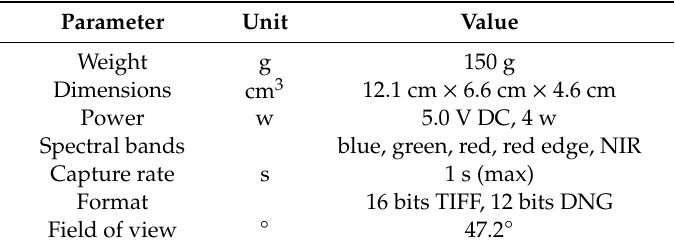
Figure 1. Rededge- M multi-spectral camera. Note: 1. Blue band 2. Green band 3. Red band 4. NIR (near infrared red) band 5. Red Edge band. Table 1. Main specifications of Rededge-M.